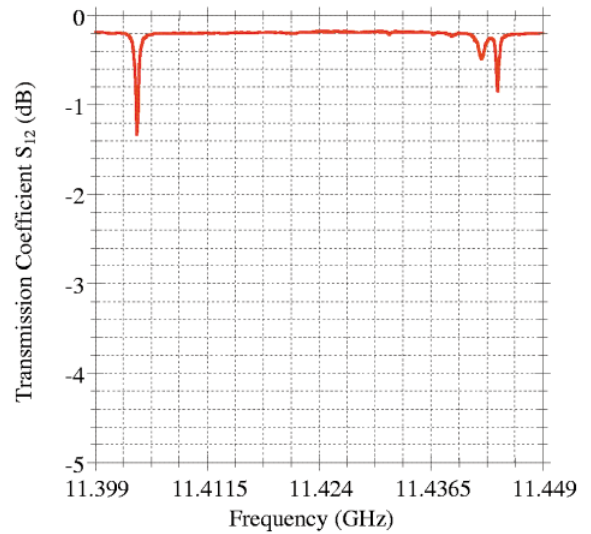
FIG. 17. (Color) The transmission through two TE 12 mode transducers connected from their circular ports using the arc